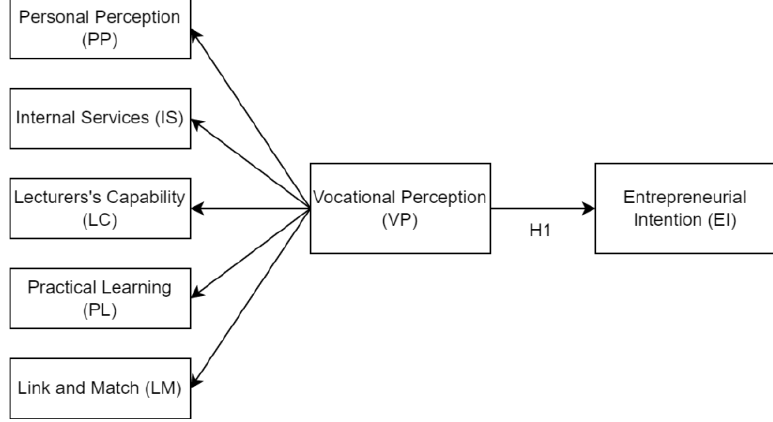
Figure 3: Conceptual Research Model, Source: